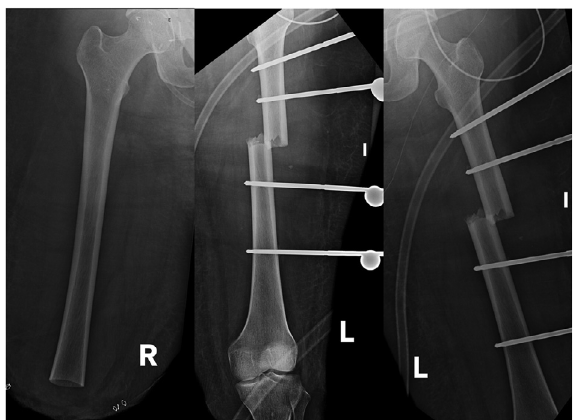
Figure 2. Femoral radiographs after damage control surgery. Right lower limb underwent a supracondylar amputation (left image). Left lower limb underwent a transtibial amputation and a femoral external fixation (middle and right